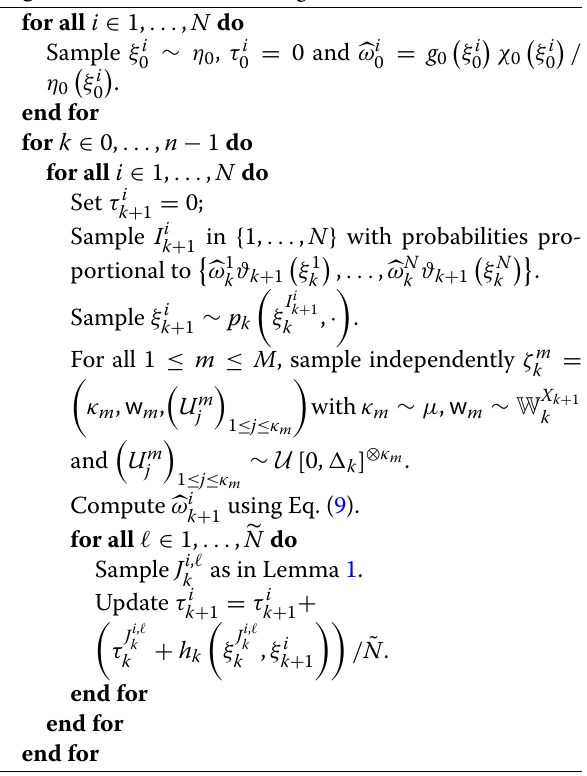
Algorithm 1 GRand PaRIS